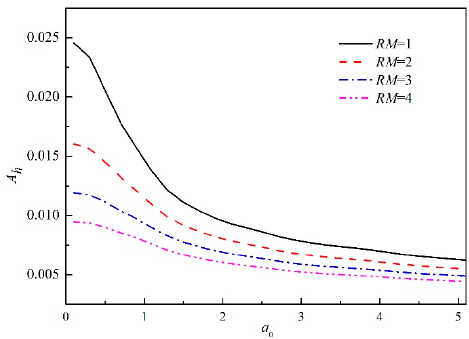
Figure 7. Dynamic response factor of embedded foundation under different mass ratio.